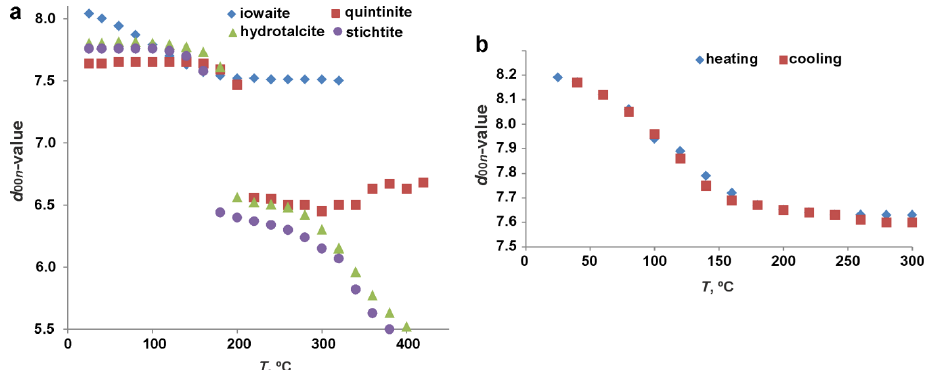
Figure 3. The evolution of d 00 n -value with increasing temperature for: ( a ) to 420 °C for quintinite, hydrotalcite, stichtite, iowaite and their corresponding HT modifications and ( b ) to 300 °C, followed by cooling to RT for iowaite (reversibility check).